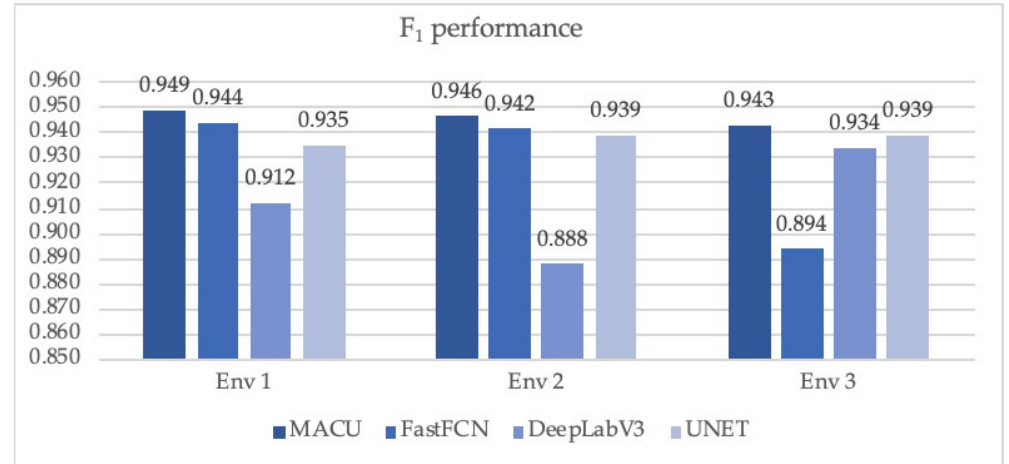
Figure 1. F 1 performance comparison in three information intensity environments obtained by the four networks (MACU, FastFCN, DeepLabv3, UNET).